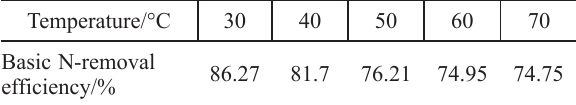
Table 2 – Effect of temperature on basic N-removal efficiency Temperature/°C